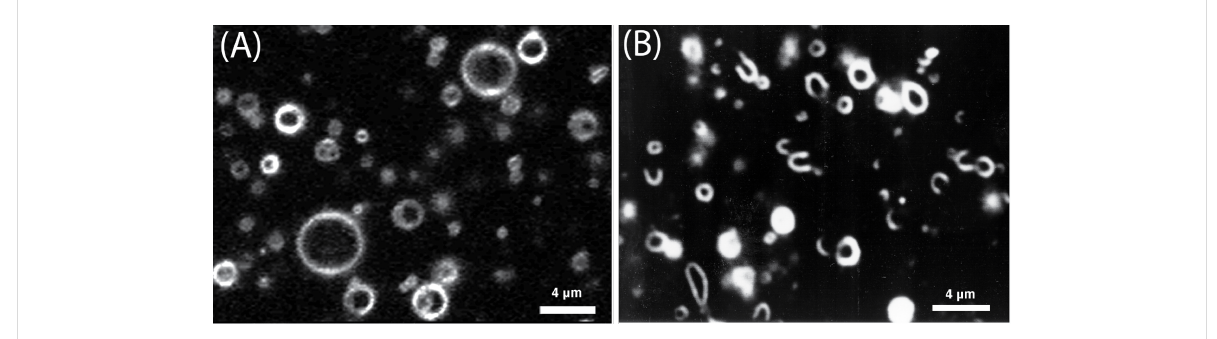
Figure 7: Transformed liposomes observed by dark-field microscopy in the presence of talin. Liposomes used were prepared from phosphatidyl- ethanolamine and phosphatidylglycerol (1:1, mol:mol). (A) Closed spherical liposomes obtained in the absence of talin. (B) Cup-shaped liposomes observed in the presence of 0.4 mM talin. Image courtesy of K. Takiguchi (unpublished).